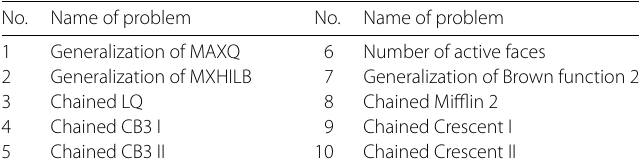
Table 1 Tested problems